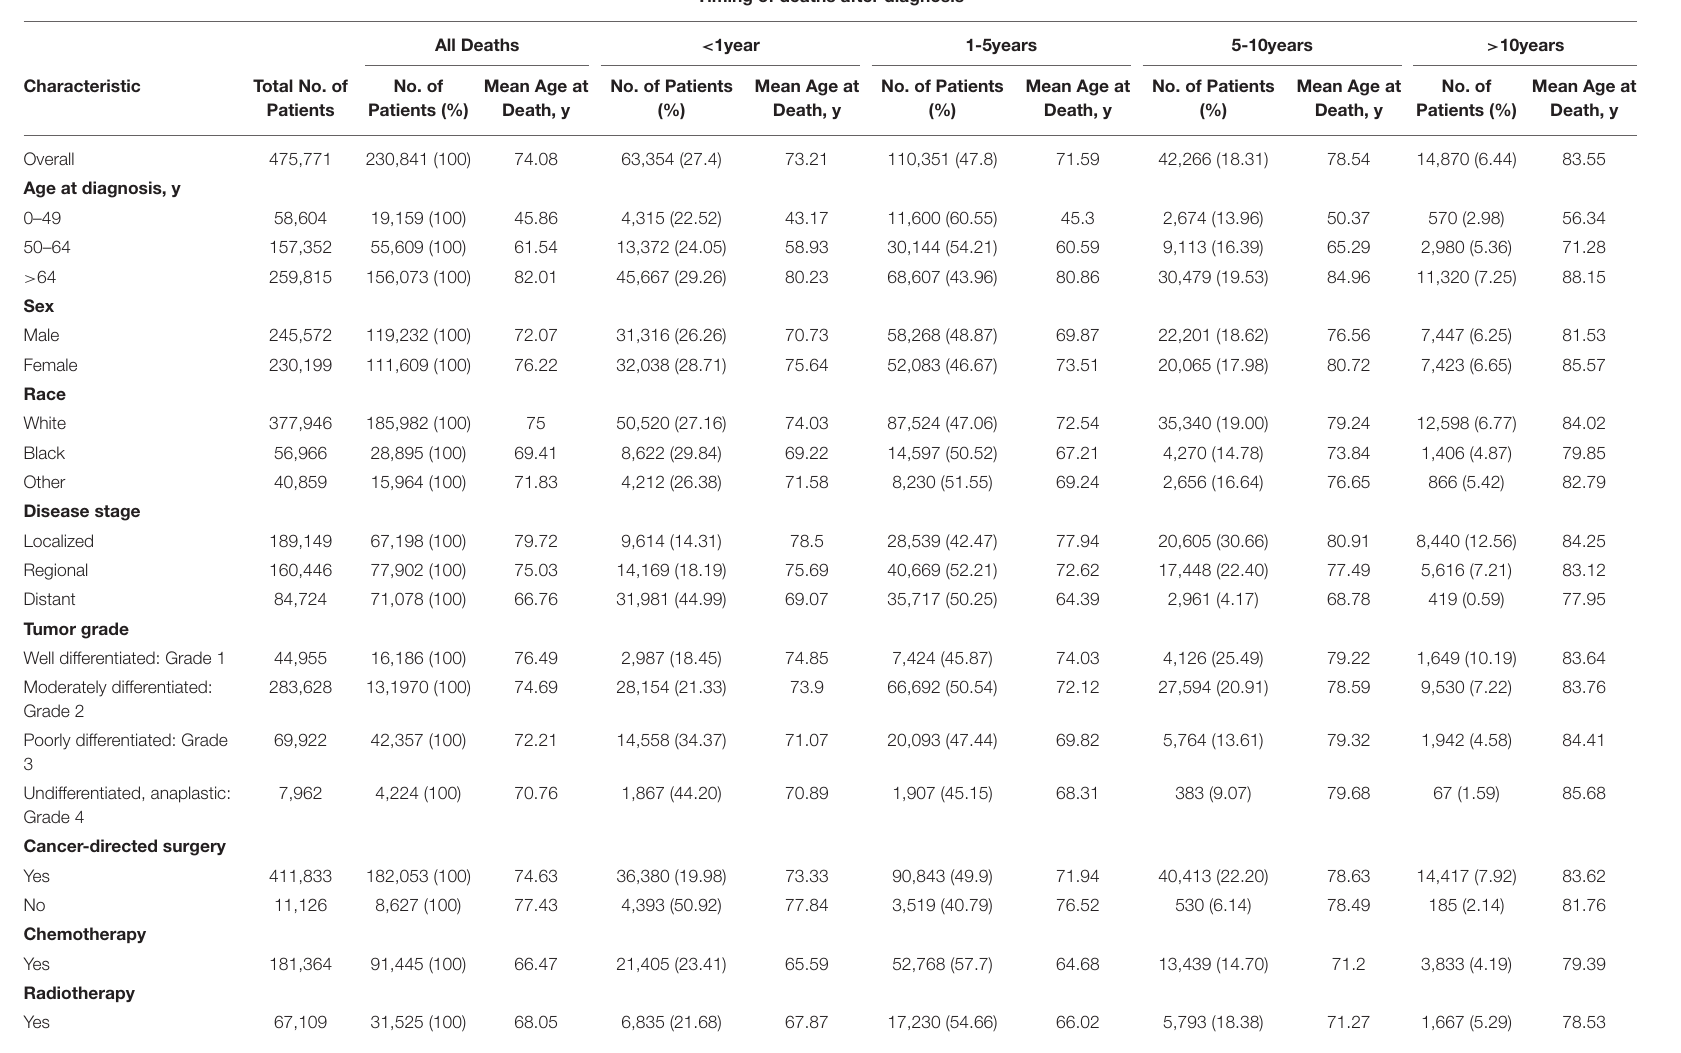
Timing of deaths after